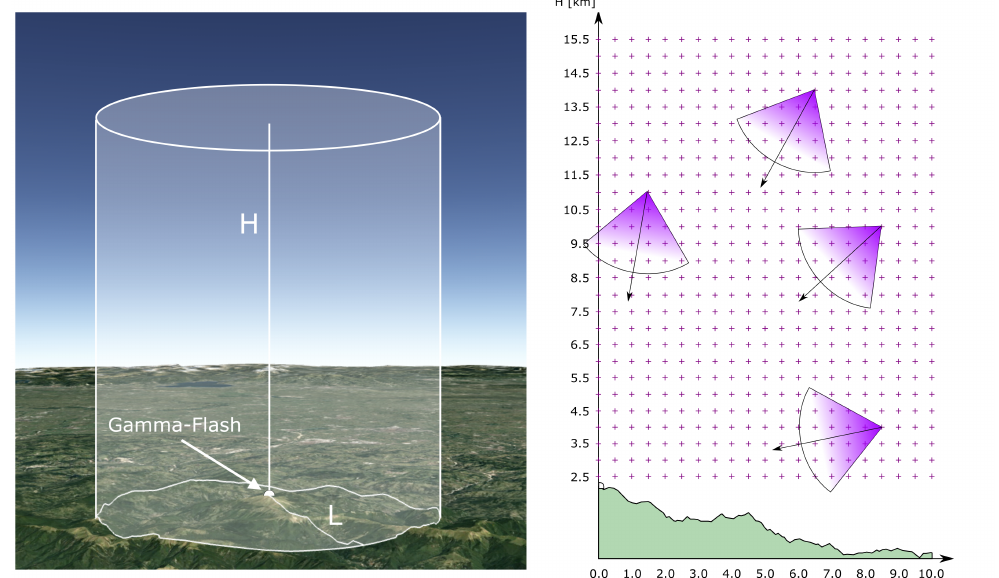
Figure 1. Left : spatial volume (white shaded) around the ground-based Gamma-Flash experiment installed on the top of Mt. Cimone (white dome), considered to evaluate the detectability region for the potential detection of TGFs. Distances on ground range within 0.0–10.0 km from the detector, and altitudes range within 2.5–15.5 km a.s.l. Right : schematic view of all the ( L , H ) potential TGF source positions (purple crosses) considered for the analysis. For all positions, we simulate TGFs characterized by emission half-angles α = 40 ◦ (purple shaded), all directed toward the Gamma-Flash detectors in ( L , H ) = (0.0 km, 2.5 km) (white